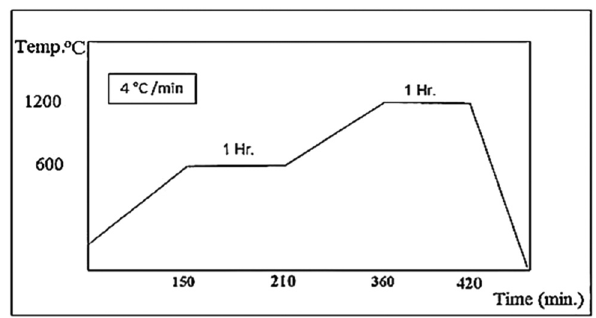
Figure 2: Firing program of the present work.